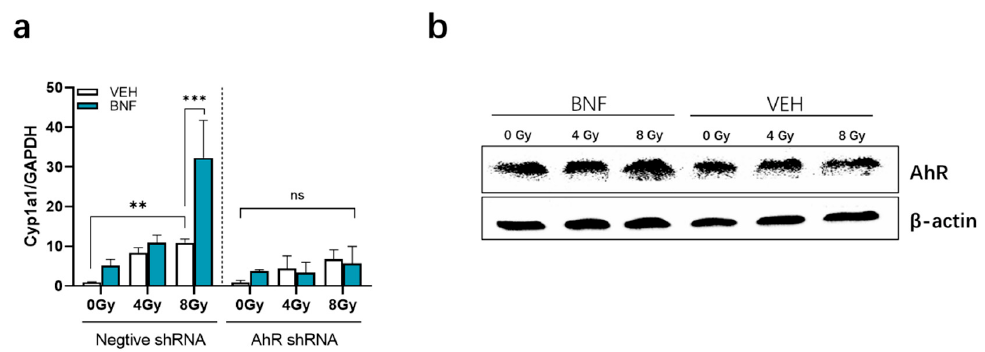
Figure 5. ( a ) Cyp1a1 gene expression in the AhR shRNA and control vector cell lines treated with 1 µ M BNF or vehicle prior to radiation exposure; ( b ) Western blot analysis of AhR protein expression in IEC-6 cells. Results are expressed as Mean ± SD and analyzed by one-way ANOVA (Significance: ** p < 0.01, *** p < 0.001). The term “ns” is defined as not significant.